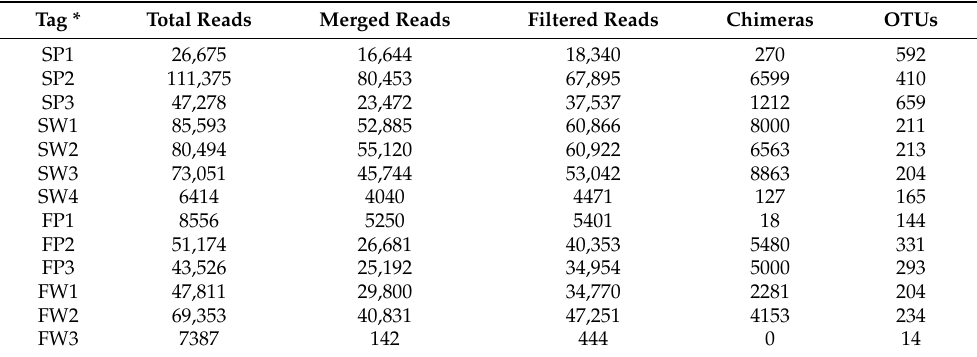
Table 2. Total number of operational taxonomic units (OTUs) resulting from the QIIME2 pipeline dataset.